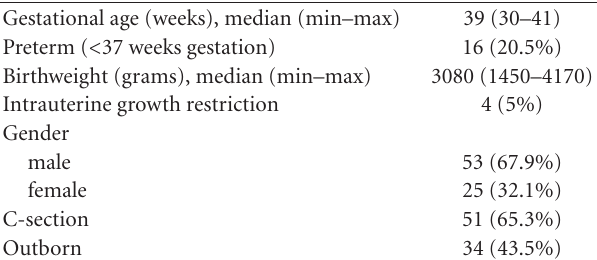
Table 1: Demographics ( n =